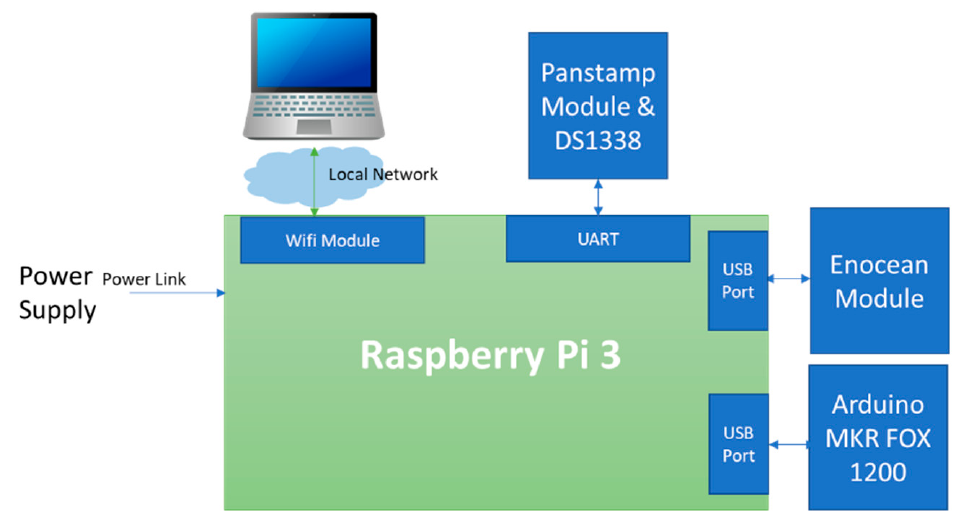
Figure 5. Block diagram of the local server.